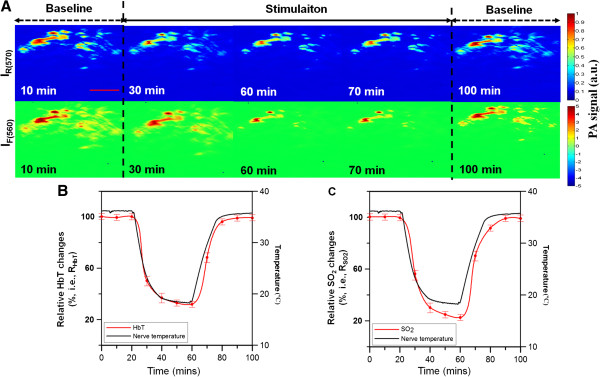
PA imaging results. (A)In vivo relative I(570) (i.e., HbT; upper panel) and IF(560) (i.e., SO2; lower panel) PA B-scan images of selected position at different times of temperature modulation protocol. Note that the I(570) and IF(560) are specifically sensitive to relative HbT and SO2 changes, respectively. The red scale bar is equivalent to 100 μm and applies to all images in panel A. Mean functional (B) HbT (i.e., RHbT) and (C) SO2 (i.e., RSO2) changes resulting from in vivo temperature modulation of the rat sciatic nerve as a function of time. The error bars indicate standard deviation (n = 10).